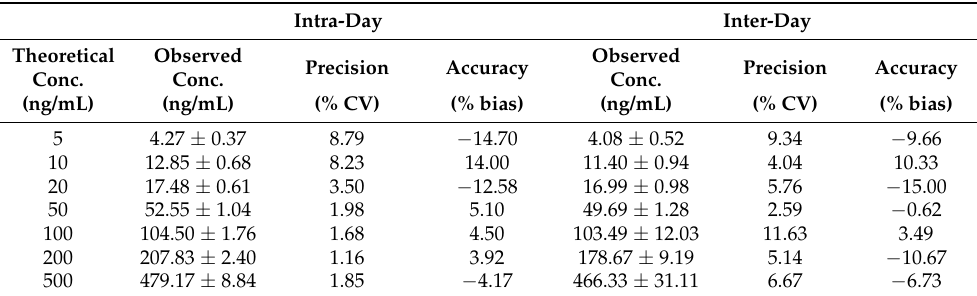
Figure 1. Product ion spectrum of erinacine A. Table 1. Intra-day and inter-day precision and accuracy of LC/MS/MS method for the determination of erinacine